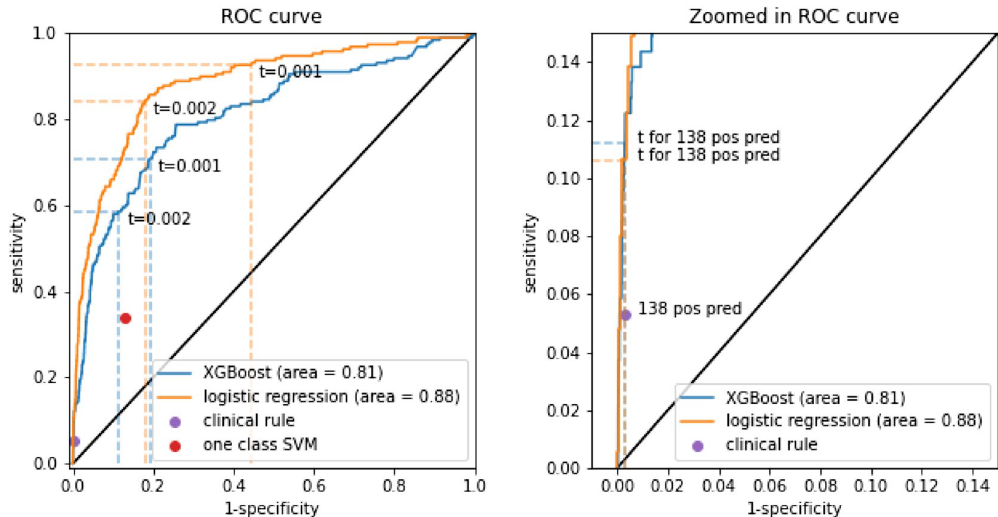
Figure 2. ROC-curve for predictions from XGBoost and the logistic regression model. The sensitivity and specificity of the one class SVM and clinical prediction rule are also plotted on the left curve. On the left the points corresponding to the 0.001 (‘t = 0.001’) and 0.002 (‘t = 0.002’) probability thresholds are plotted for the XGBoost and logistic regression model. On the right the points corresponding to the thresholds resulting in 138 positive predictions (‘t for 138 pos pred’, equaling the clinical rule positive predictions) are plotted for the XGBoost and logistic regression model.